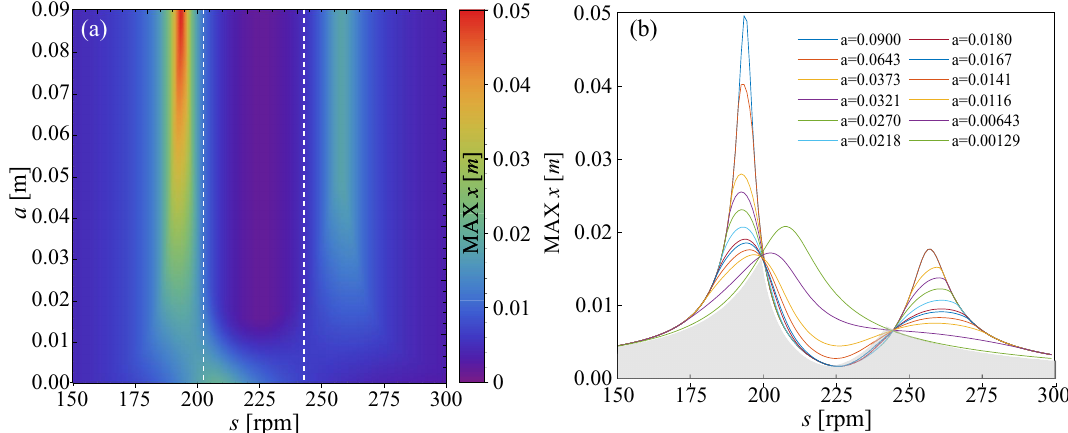
Figure 7. In panel ( a ) we show two dimensional plot of maximum amplitude of damped system (max x [ m ] ) in two parameters of space: a and s for damping function given by equation (Equation (7)). Panel ( b ) shows twelve exemplary FRCs of damped